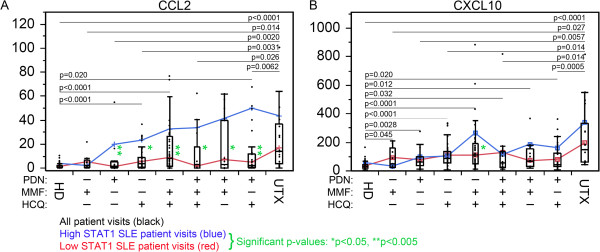
The expression of CCL2 and CXCL10 in high versus low STAT1 patient subsets with individual and combined therapy. (A) CCL2 levels in HD (healthy donor), untreated (UTX), and other patient visits under treatment with different combinations of PDN, MMF, and HCQ were plotted (black bars). Only significant differences comparing each treatment group to either HD or UTX are indicated as black lines with P value shown. Data segregating into high STAT1 (blue line) and low STAT1 (red line) subsets are also shown and significant differences for these subsets are indicated by green asterisks. (B) CXCL10 data were analyzed similarly. CCL2, C-C motif chemokine ligand 2; CXCL10, C-X-C motif chemokine 10; HCQ, hydroxychloroquine; HD, healthy donor; IFN, interferon; MMF, mycophenolate mofetil; PDN, prednisone; SLE, systemic lupus erythematosus; SLEDAI, SLE disease activity index; STAT1, signal transducer and activator of transcription 1.